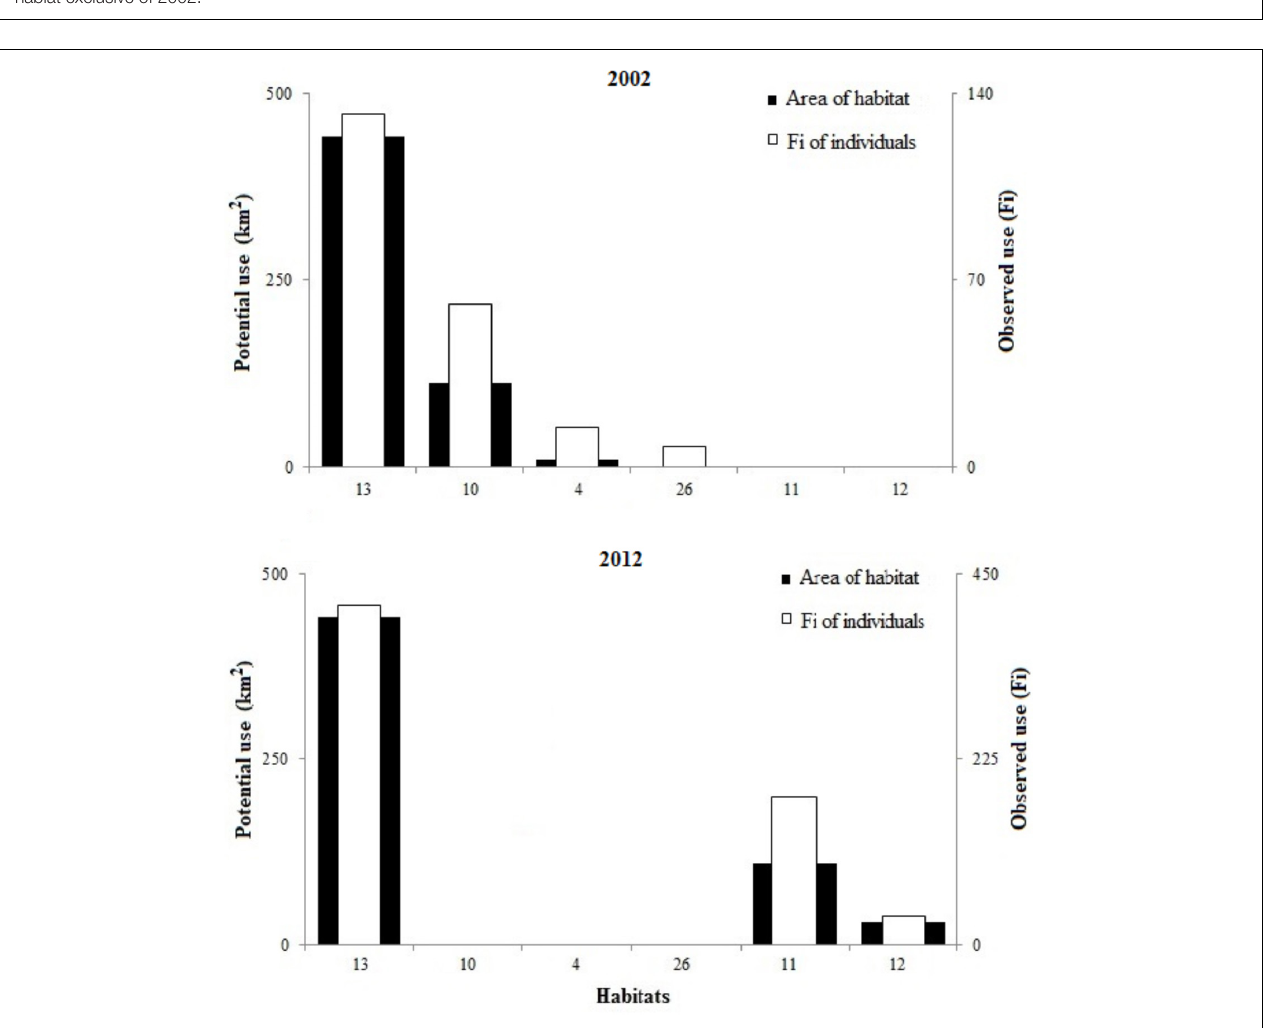
FIGURE 5 | Habitat used by individual D. cylindrus (including colonies and fragments), in terms of absolute frequency (Fi, white) and area of the six potential habitats (black), in 2002 and